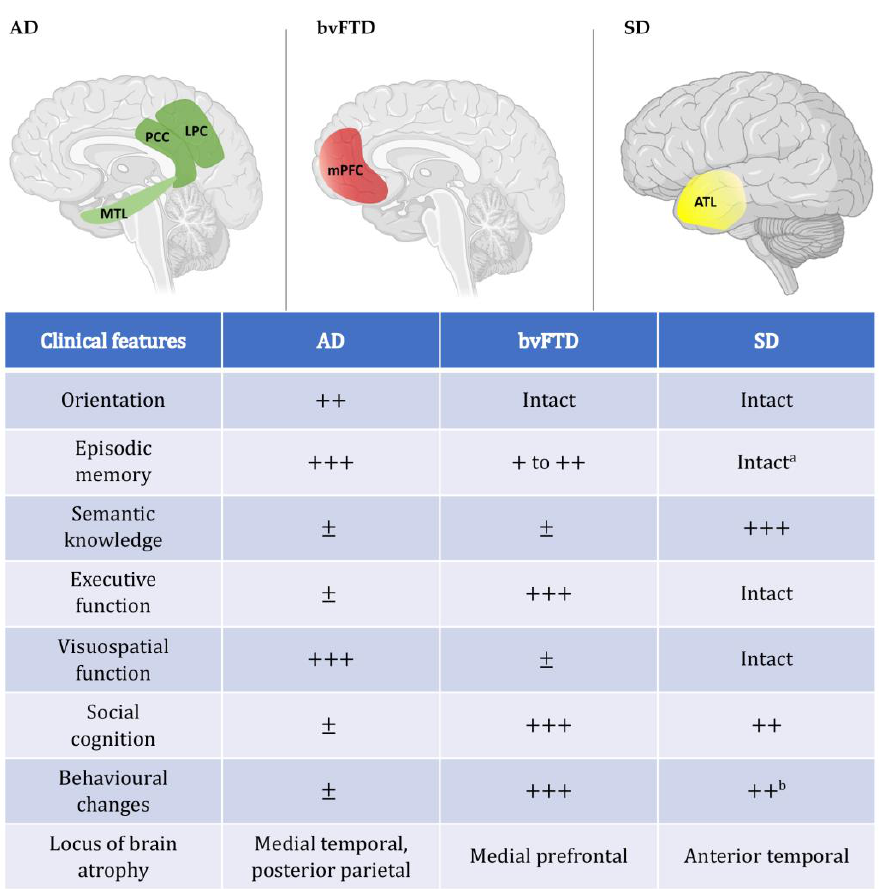
Figure 3. Top panel displays canonical epicentres of atrophy in the clinical syndromes of